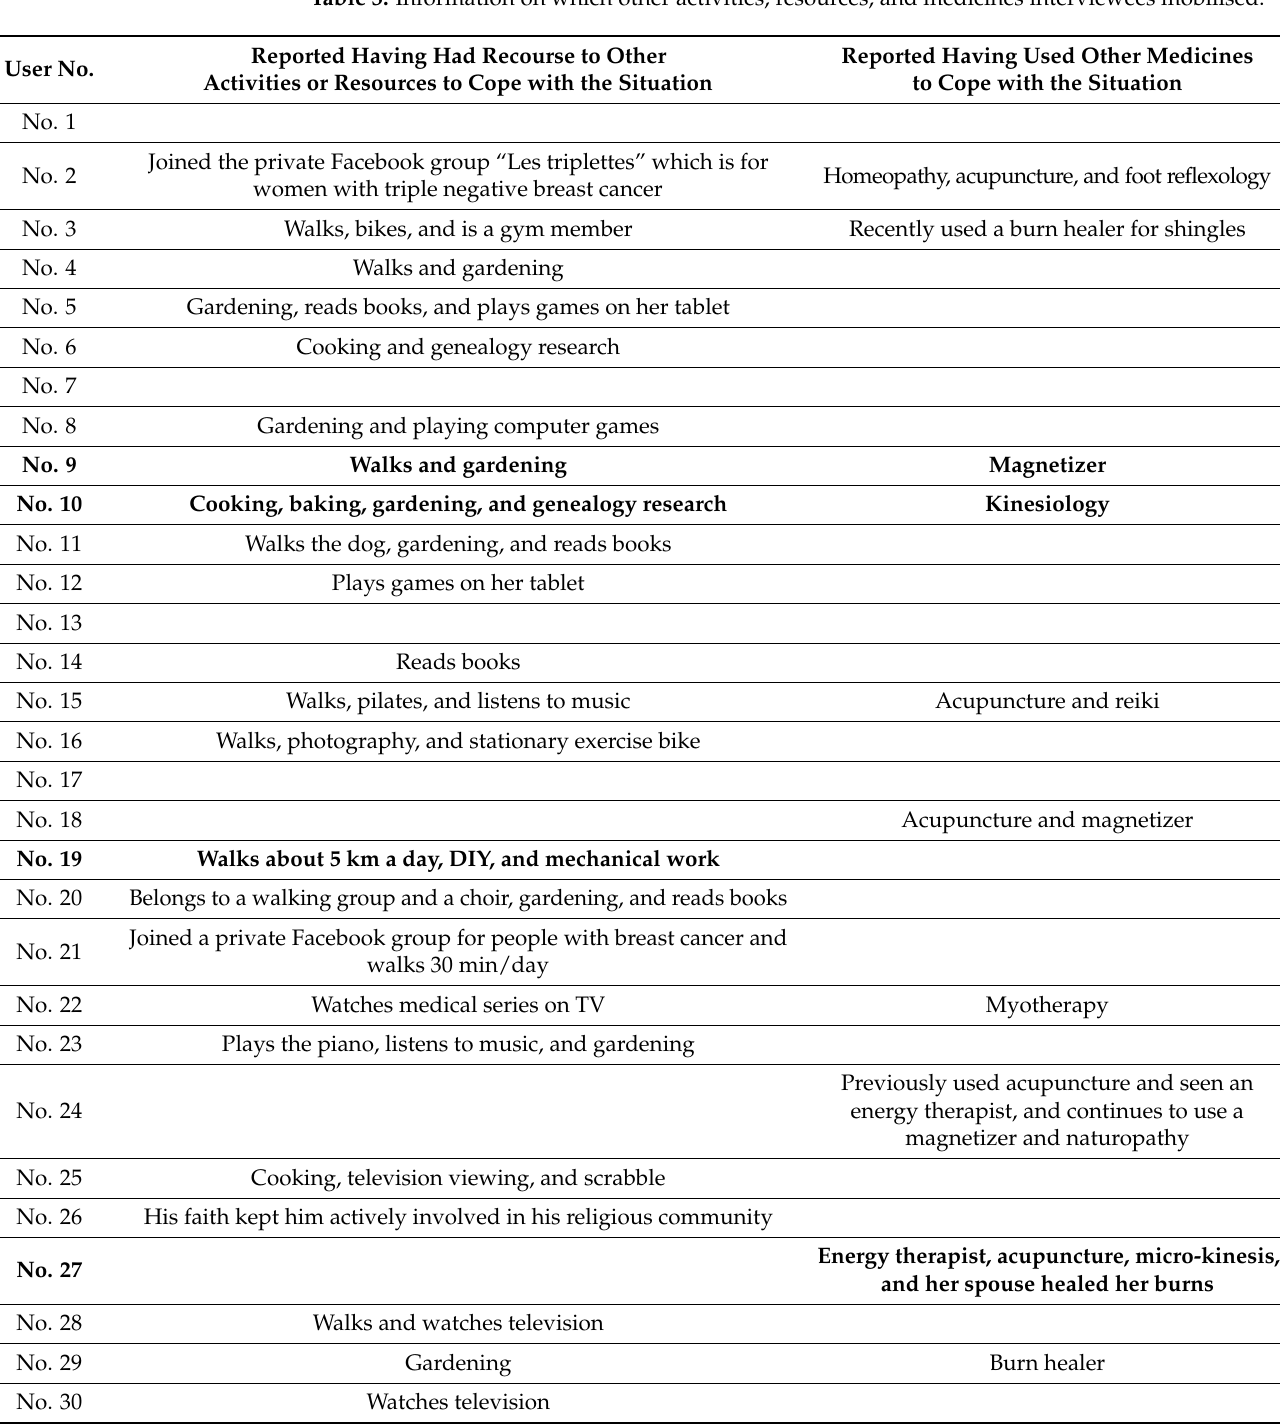
Table 3. Information on which other activities, resources, and medicines interviewees